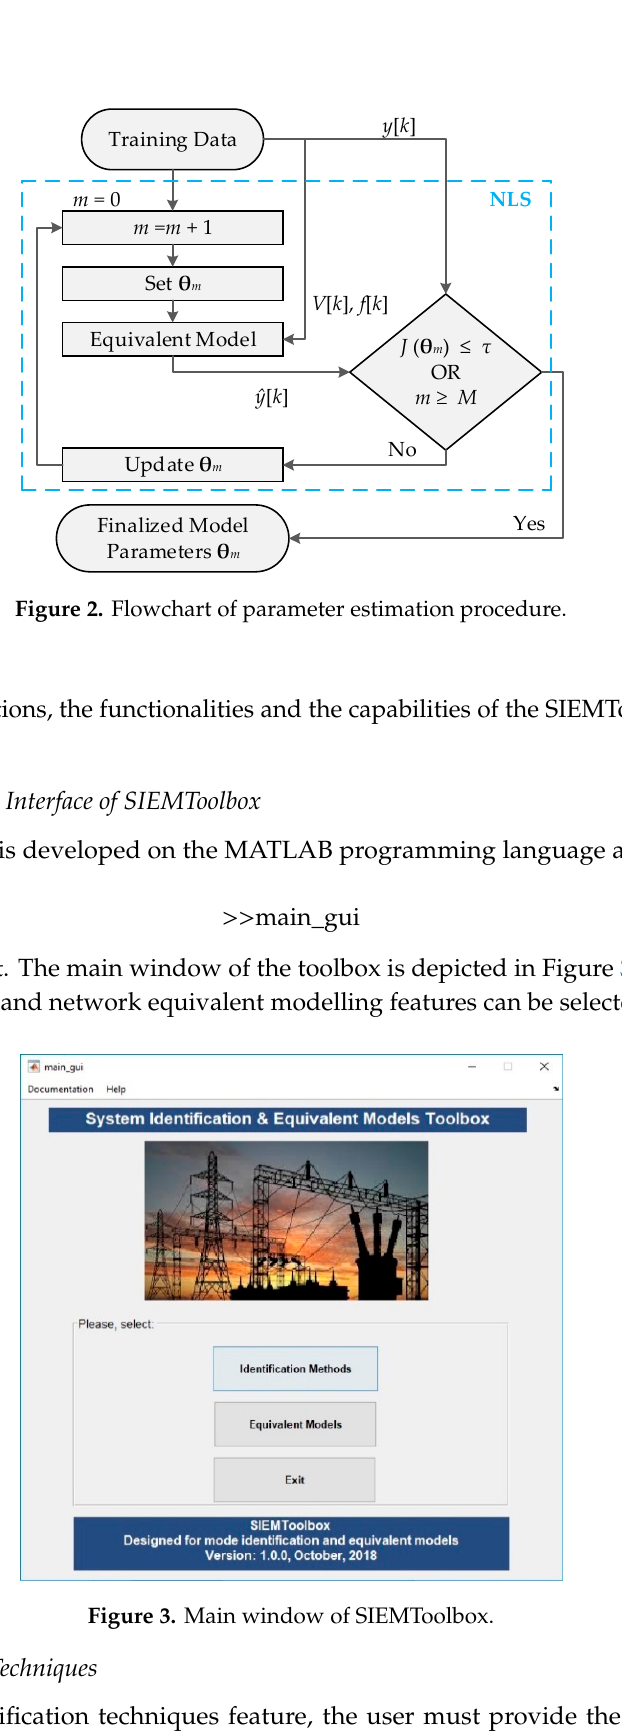
Figure 3. Main window of SIEMToolbox.